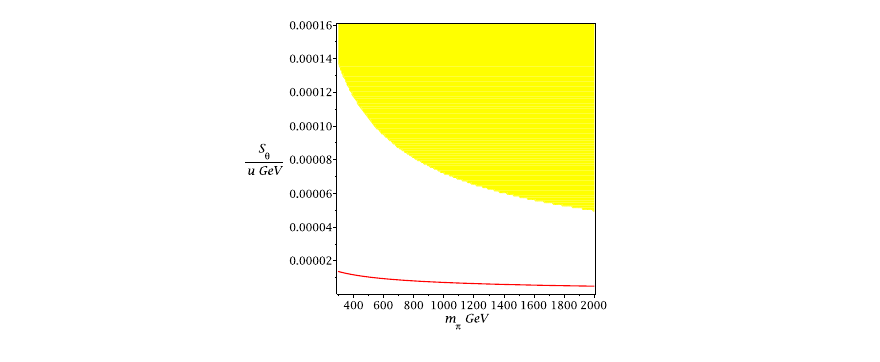
Figure 1. Phase diagram in terms of S θ / u and m ˜ π parameters, the yellow regions is forbidden from direct experiments of the XENON and LUX collaborations. All regions above the red line will be excluded by future experiments in the next ten